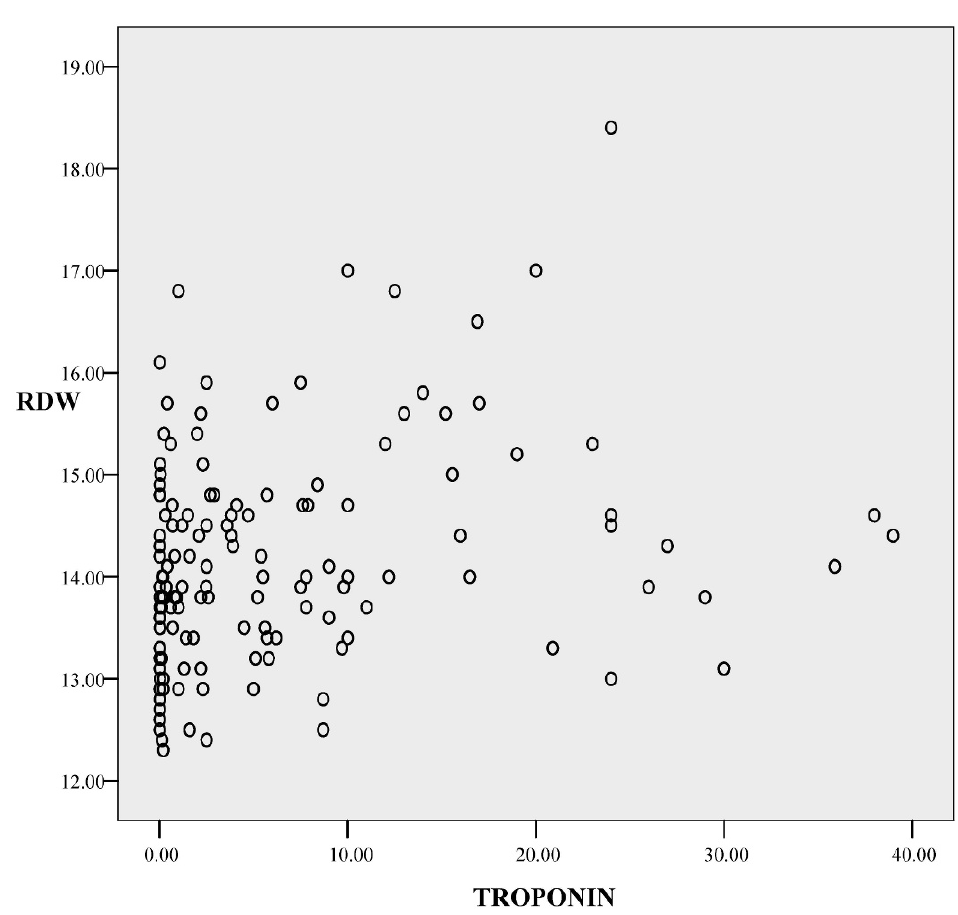
Figure 1 - Correlation between RDW and the cardiac troponin values (r=0.19; p